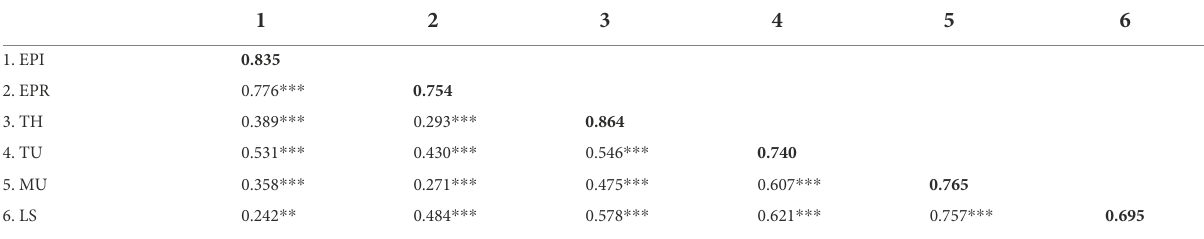
TABLE 3 The results of discriminate validity ( N = 203).